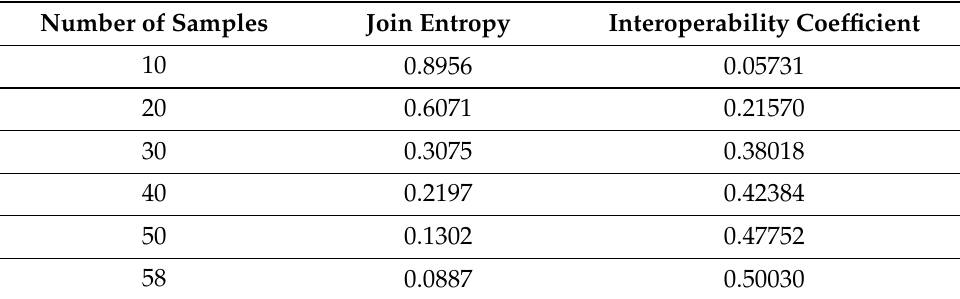
Table 2. Minimum real samples estimation for building VR environment.